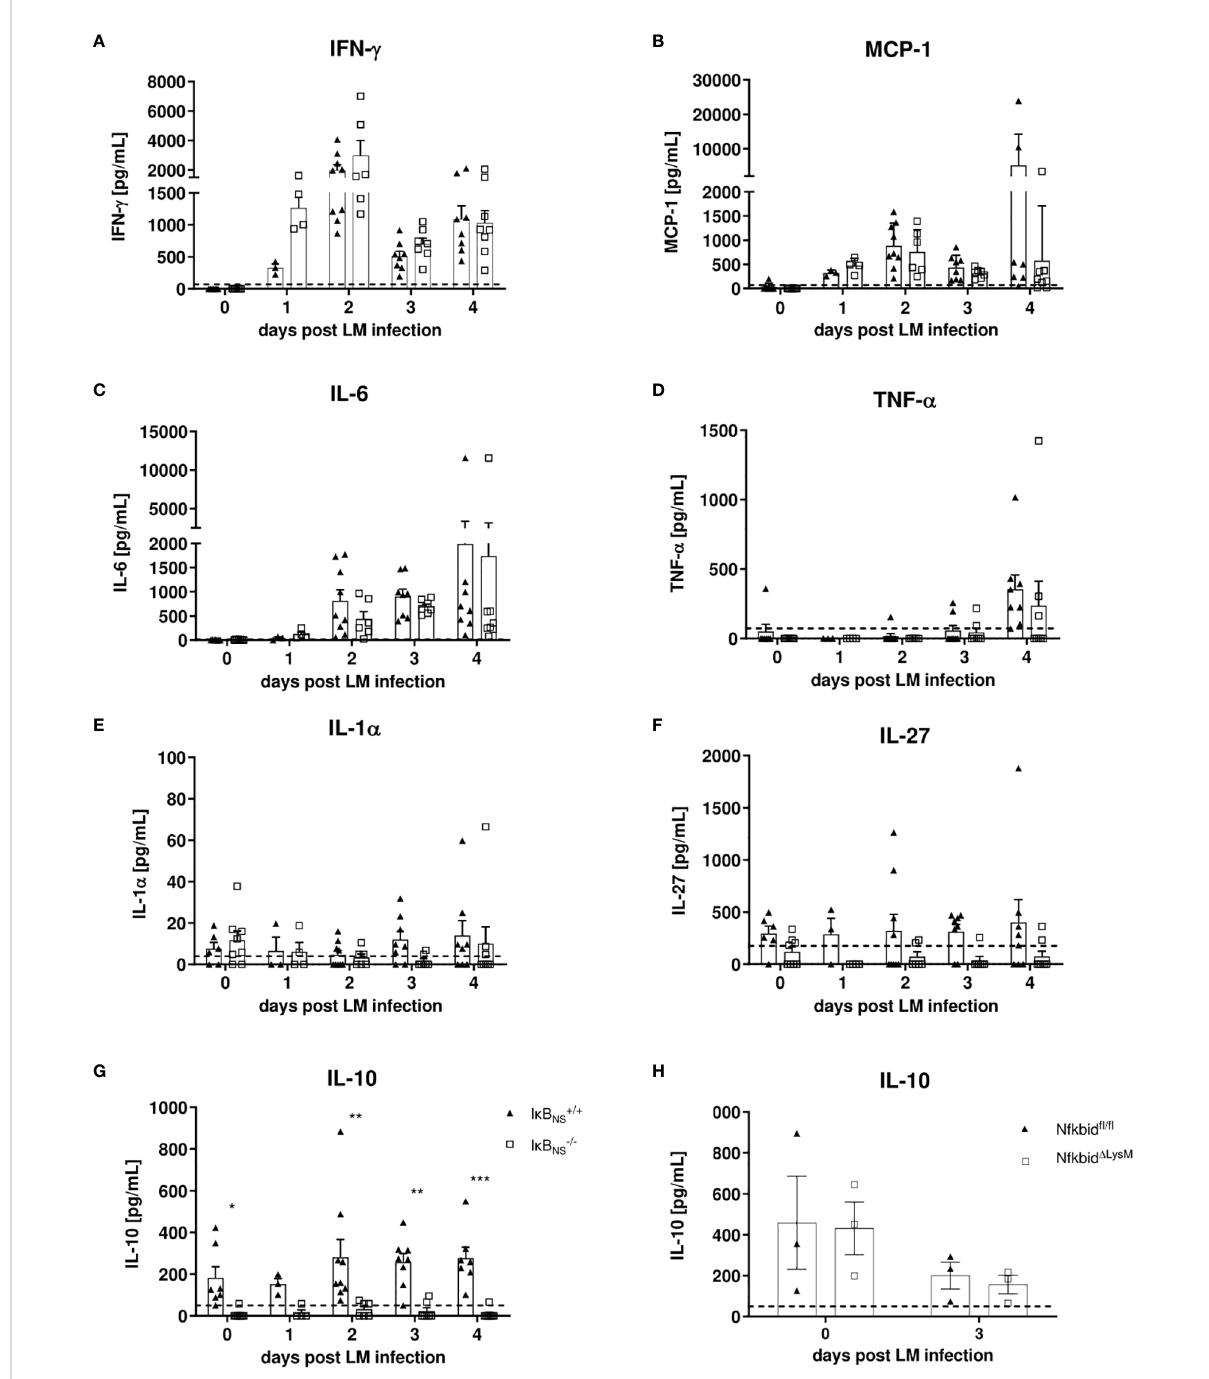
FIGURE 7 Analysis of pro-in fl ammatory mediators in serum samples during the course of Lm infection. I k B NS+/+ and I k B NS-/- mice were infected with 10 5 CFU Lm and heart blood was collected at the indicated times and sera was collected and used for detection of pro-in fl ammatory mediators via cytometric bead array. Shown are the mean ± SEM from (A) IFN- g , (B) MCP-1, (C) IL-6, (D) TNF- a , (E) IL-1 a , (F) IL-27 and (G) IL-10 from n=7-9 mice pooled from two independent performed experiments. (H) Serum IL-10 analysis of Lm infected Nfkbid D LysM mice and Nfkbid fl / fl littermate controls mice. Statistical analyses were performed with two-way ANOVA with Bonferroni post-hoc test. *p < 0.05, **p < 0.01, ***p <